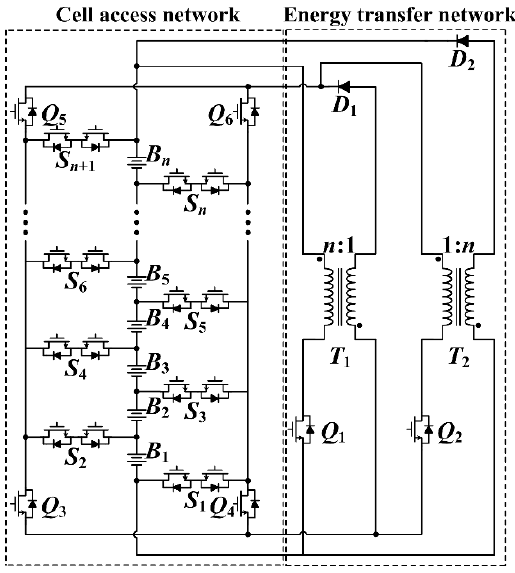
Figure 2. Circuit structure of the proposed active balancing circuit using double energy carriers.